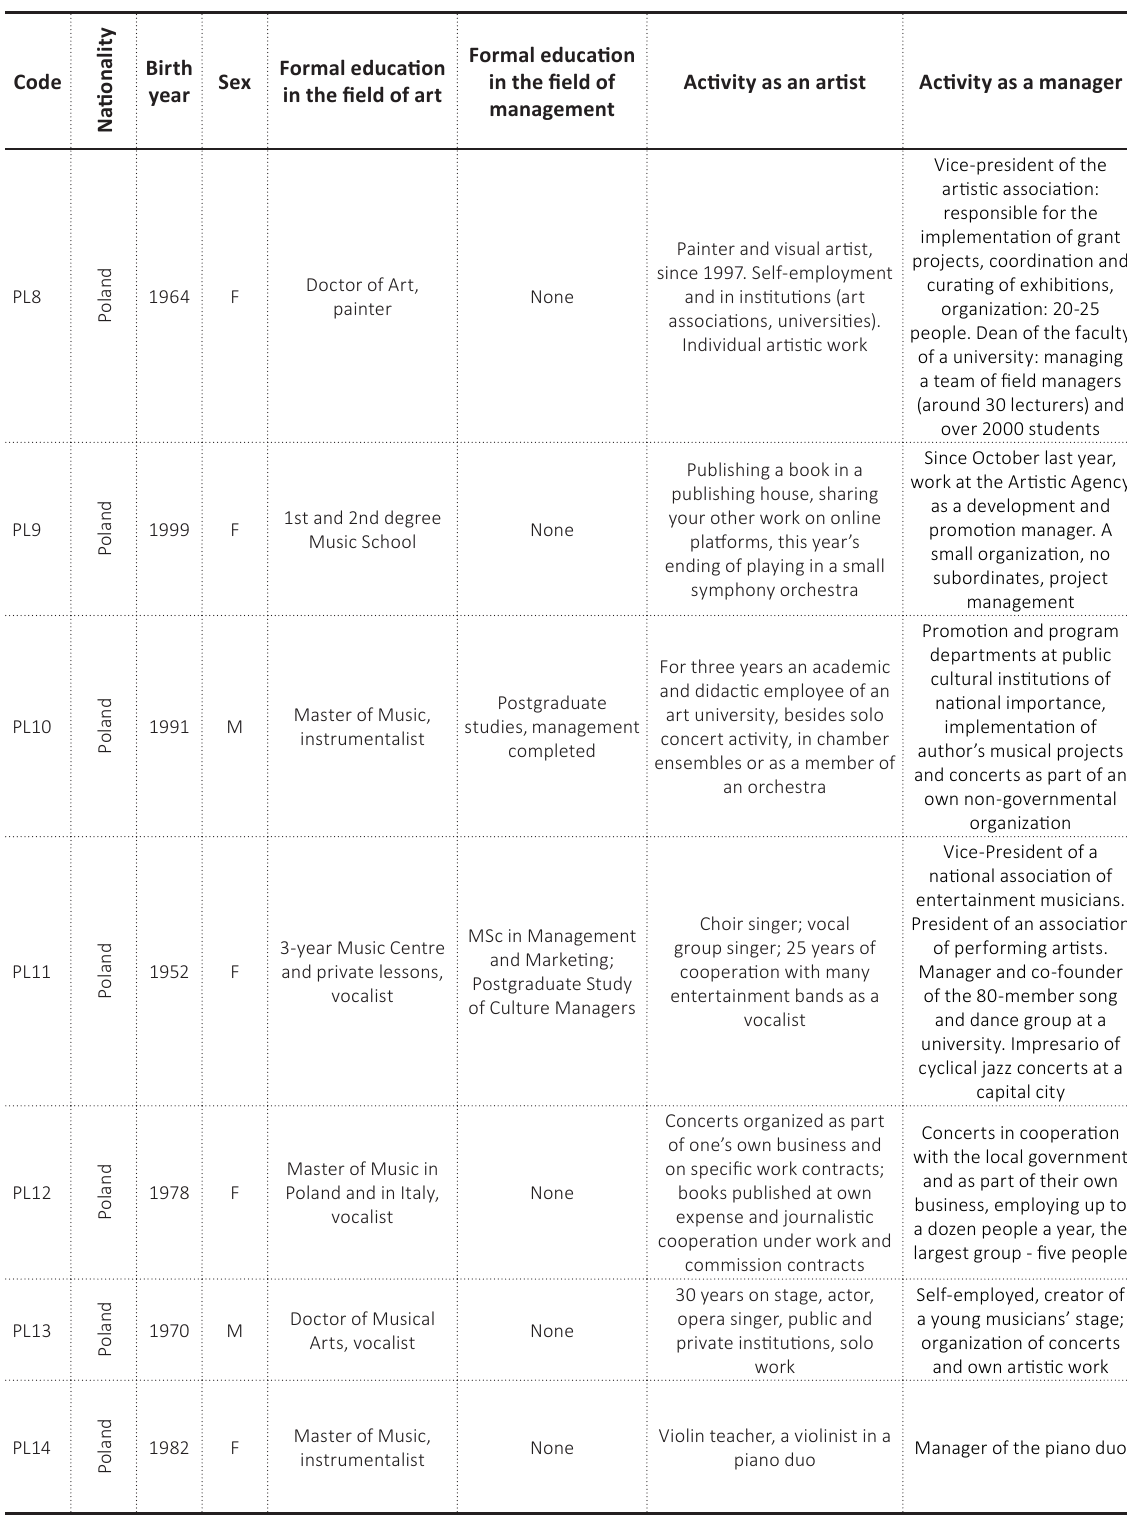
Table A1 (cont.). Description of the research